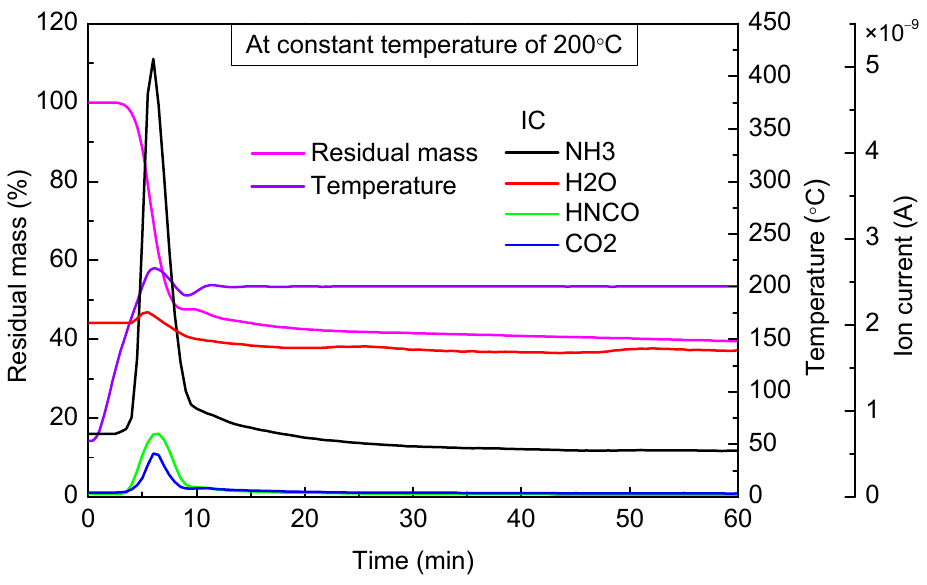
Figure 5. TG-MS results of urea at constant temperature of 200 °C.